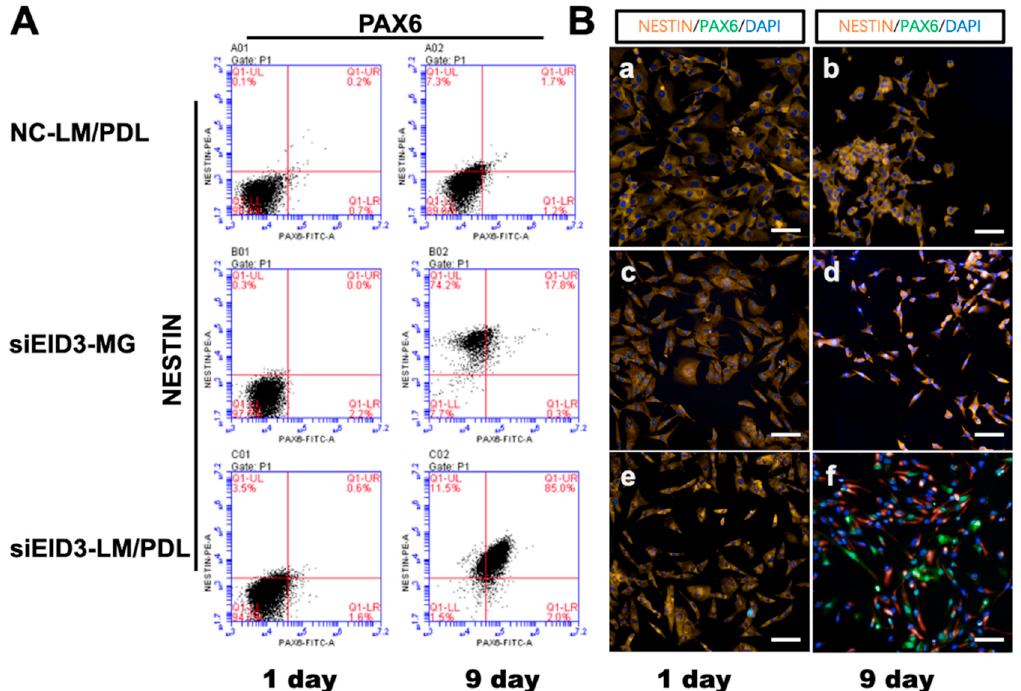
Figure 6. Immunophenotyping changes after tdASC induction. ( A ). FCM analysis of NSC markers NESTIN and PAX6 after tdASC induction was carried out with negative control, siEID3-Matrigel, and siEID3-LM/PDL groups on days 1 and 9. Representative images for each group and differentiation condition are shown. NC, negative siRNA control; LM/PDL, laminin/poly- D -lysine. ( B ). Immunocytochemistry analysis of NSC markers NESTIN and PAX6 after tdASC induction was carried out with negative control, siEID3-MG, and siEID3-LM/PDL groups on days 1 and 9. ( a , b ) Negative control groups, ( c , d ) siEID3 on Matrigel matrix, and ( e , f ) siEID3 on laminin/poly- D -lysine matrix were stained for PAX6 (green), NESTIN (red), and DAPI (blue).Scale bars: 50 µ m. Representative images for each group and differentiation condition are shown. NC, negative siRNA control; LM/PDL, laminin/poly- D -lysine; MG, Matrigel.